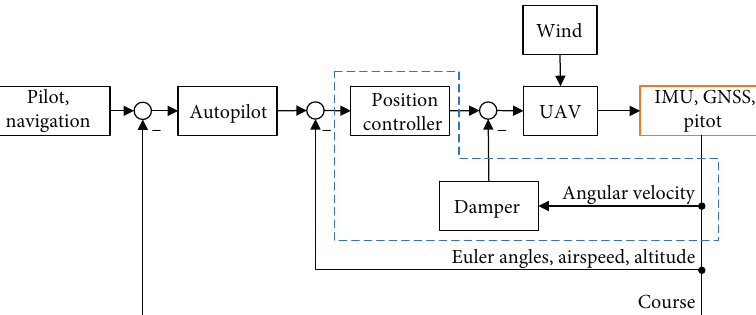
Figure 10: Development of the cascade control loop. To control the navigation course, airspeed, altitude, and Euler angles, an IMU, GNSS, and pitot tube sensor are needed. On the left side, the navigation system or the pilot commands the course the airframe should fl y. The control deviation is transferred to the autopilot which calculates the needed roll angle to reach the desired course. The autopilot also commands the airspeed and required altitude. The commands were compared to the sensor data. The internal basic controller in the blue dashed frame ensures that the airframe reaches the fi nal position.